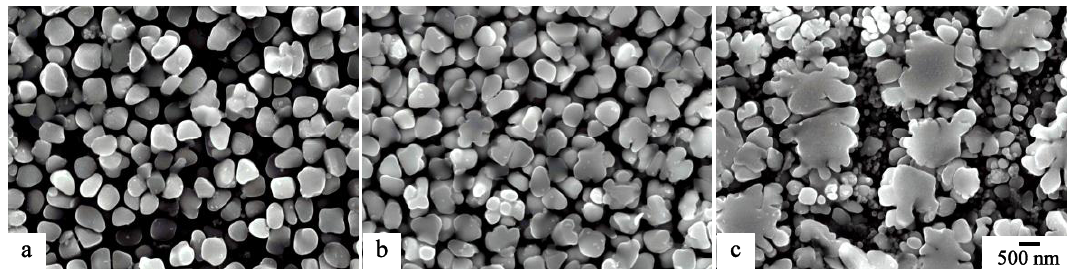
Figure 8. Microstructures of the D4 alloy aged at 1123 K for 1 h showing microstructure heterogeneity: Granular-shaped precipitates ( a ), irregular-shape precipitates ( b ), and residual intragranular precipitates ( c ).